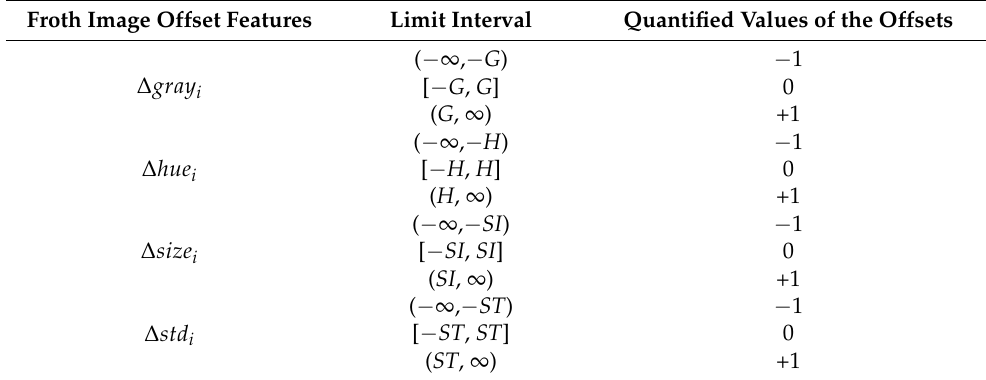
Table 7. Limit intervals and quantified values of the offsets for froth image